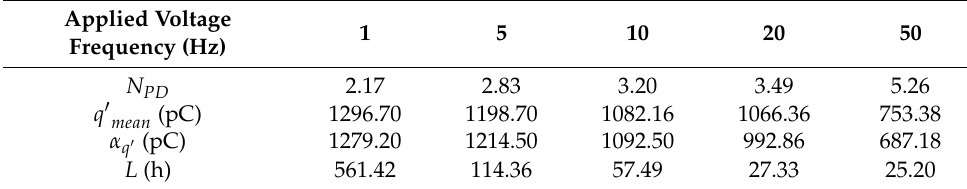
Table 6. Summary of the typical simulation results for each applied voltage frequency in the third case study.